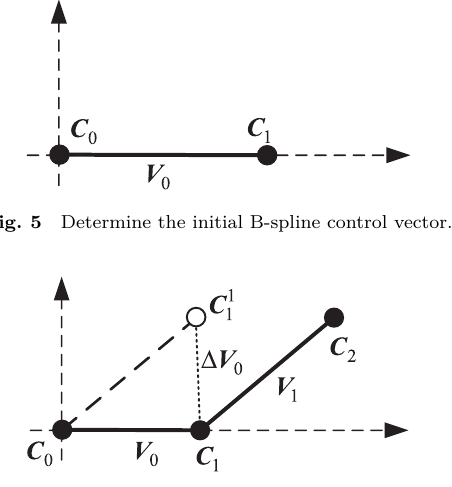
Fig. 6 Determine the second control